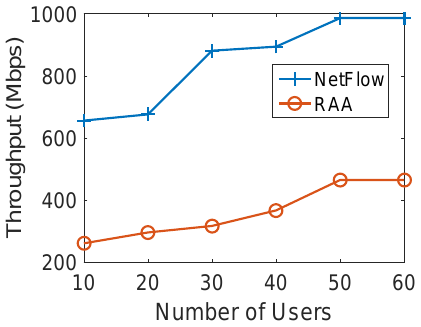
Figure 9. Throughput for varied numbers of users with 20 APs.